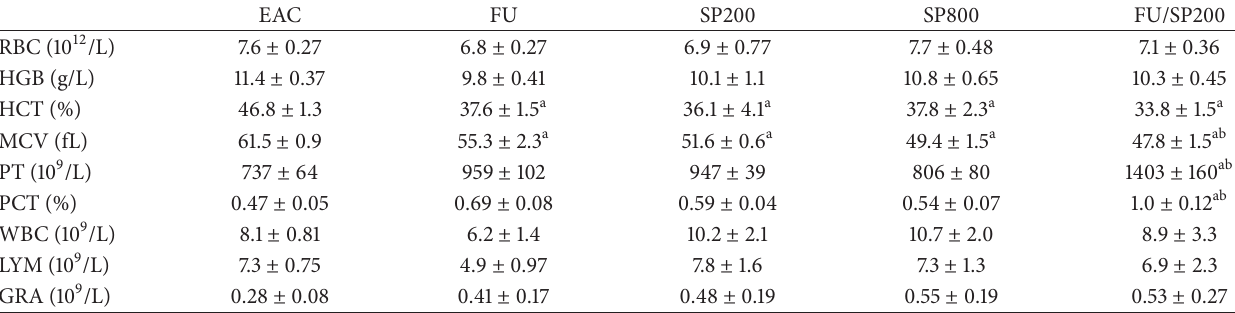
Table 2: Effects of 5-fluorouracil (20 mg/kg), spirulina (200 or 800 mg/kg), and their combination on hematological parameters of EAC tumor-bearing mice.